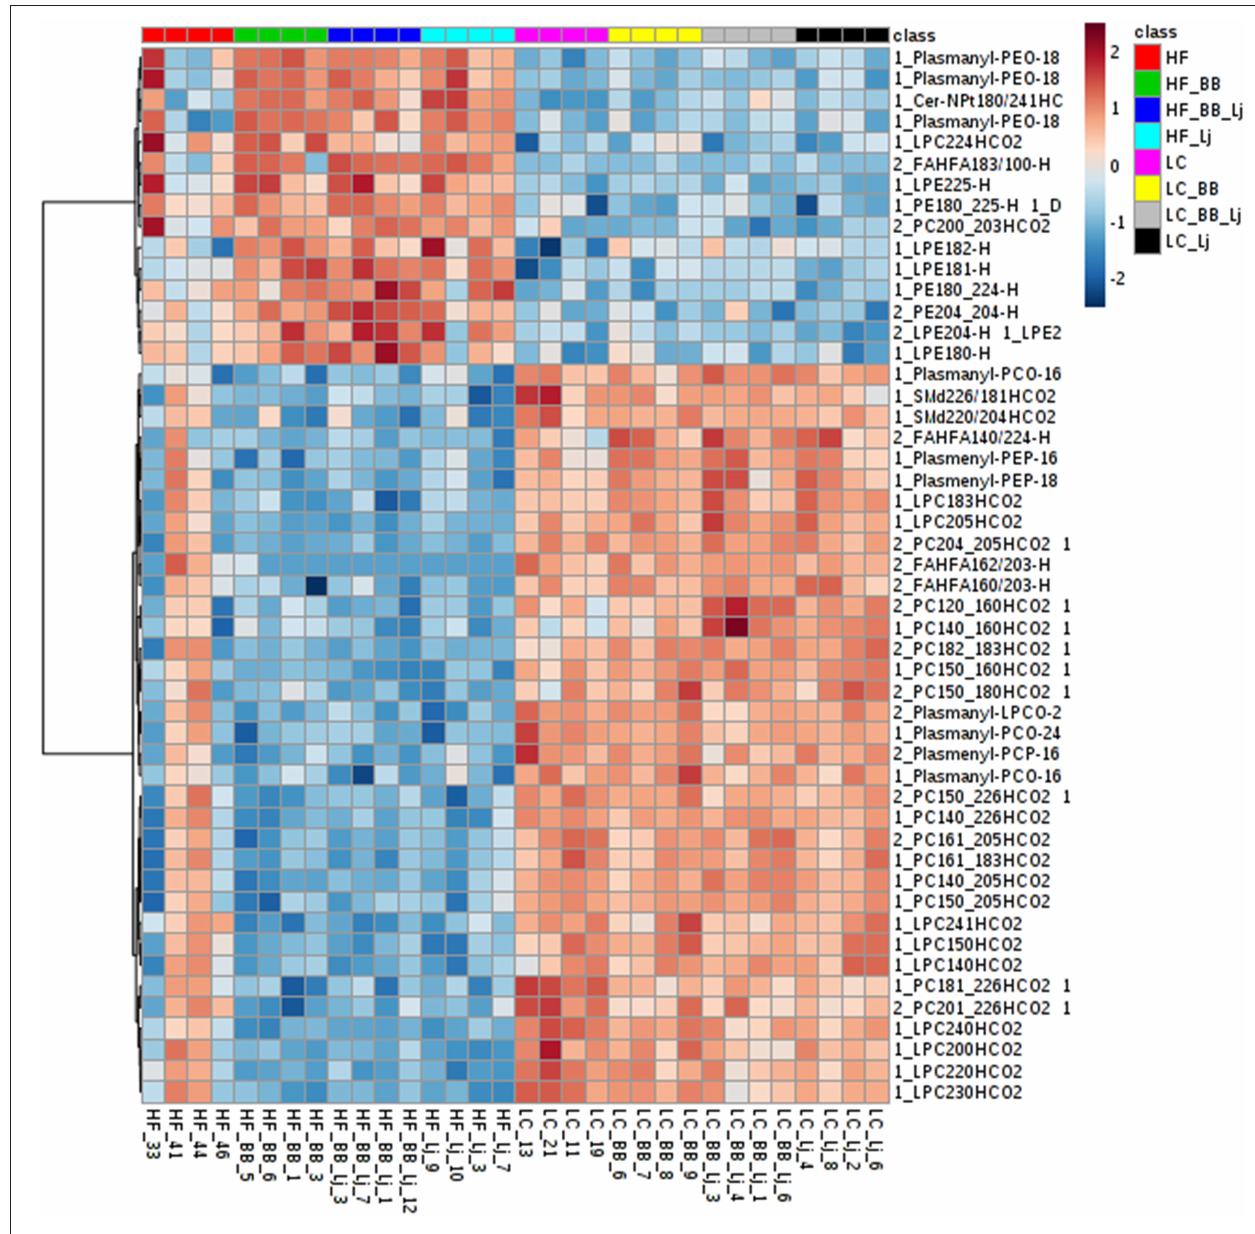
FIGURE 3 | A heatmap of the top 50 lipids species observed on serum samples ranked by T -test to retain the most contrasting pattern. Each colored cell on the map corresponds to a concentration value. Values were measured by Euclidean distance with a Ward clustering algorithm ( n = 6 per group). HF, high-fat diet; LC, low-calorie diet; BB, blueberry extract; LJ, L. johnsonii N6.2; BB/LJ, blueberry extract + L. johnsonii